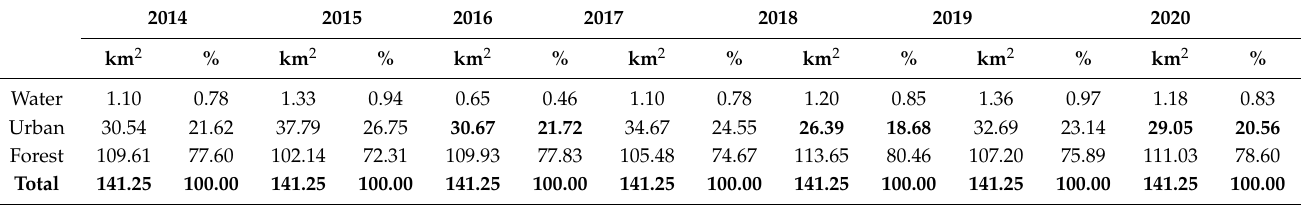
Table 6. Visual classification: variation in deforested and forest covered areas per year (km 2 ).